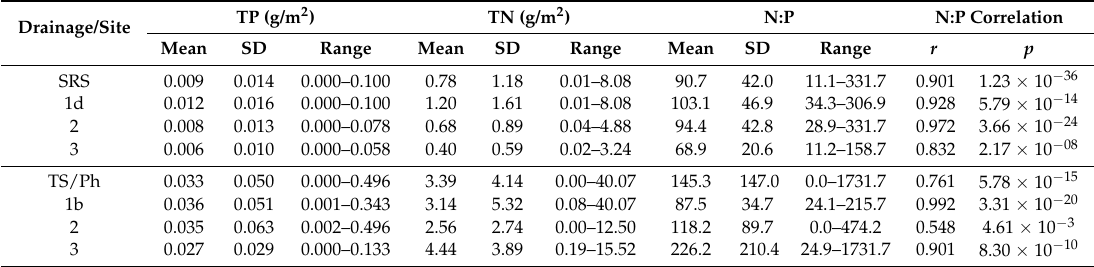
Table 4. Results of correlation analysis of periphyton mat standing stock mass N:P and water